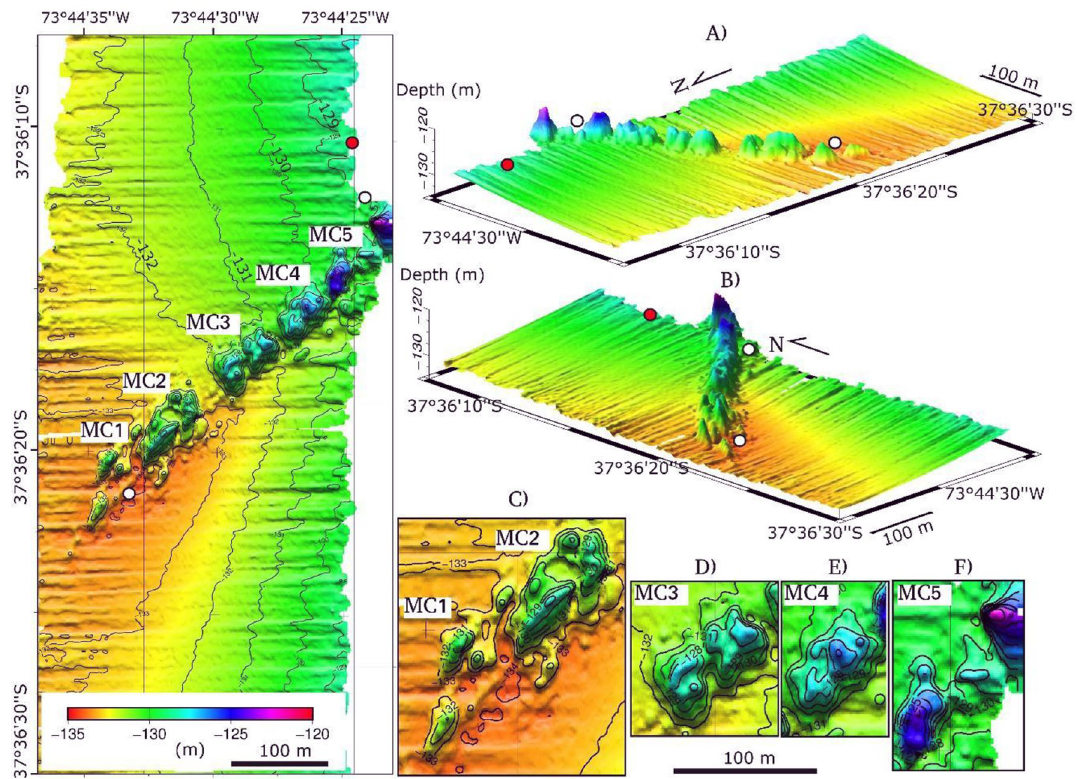
Figure 2. Bathymetric map indicating location corer GC-02 (red circle), water samples (white circles) and identified mud cones (MC1, MC2, MC3, MC4 and MC5). In ( A ) and ( B ) 3D images with orientation NW and SW respectively, while in ( C ), ( D ), ( E ) and ( F ) zooms for mud cones are